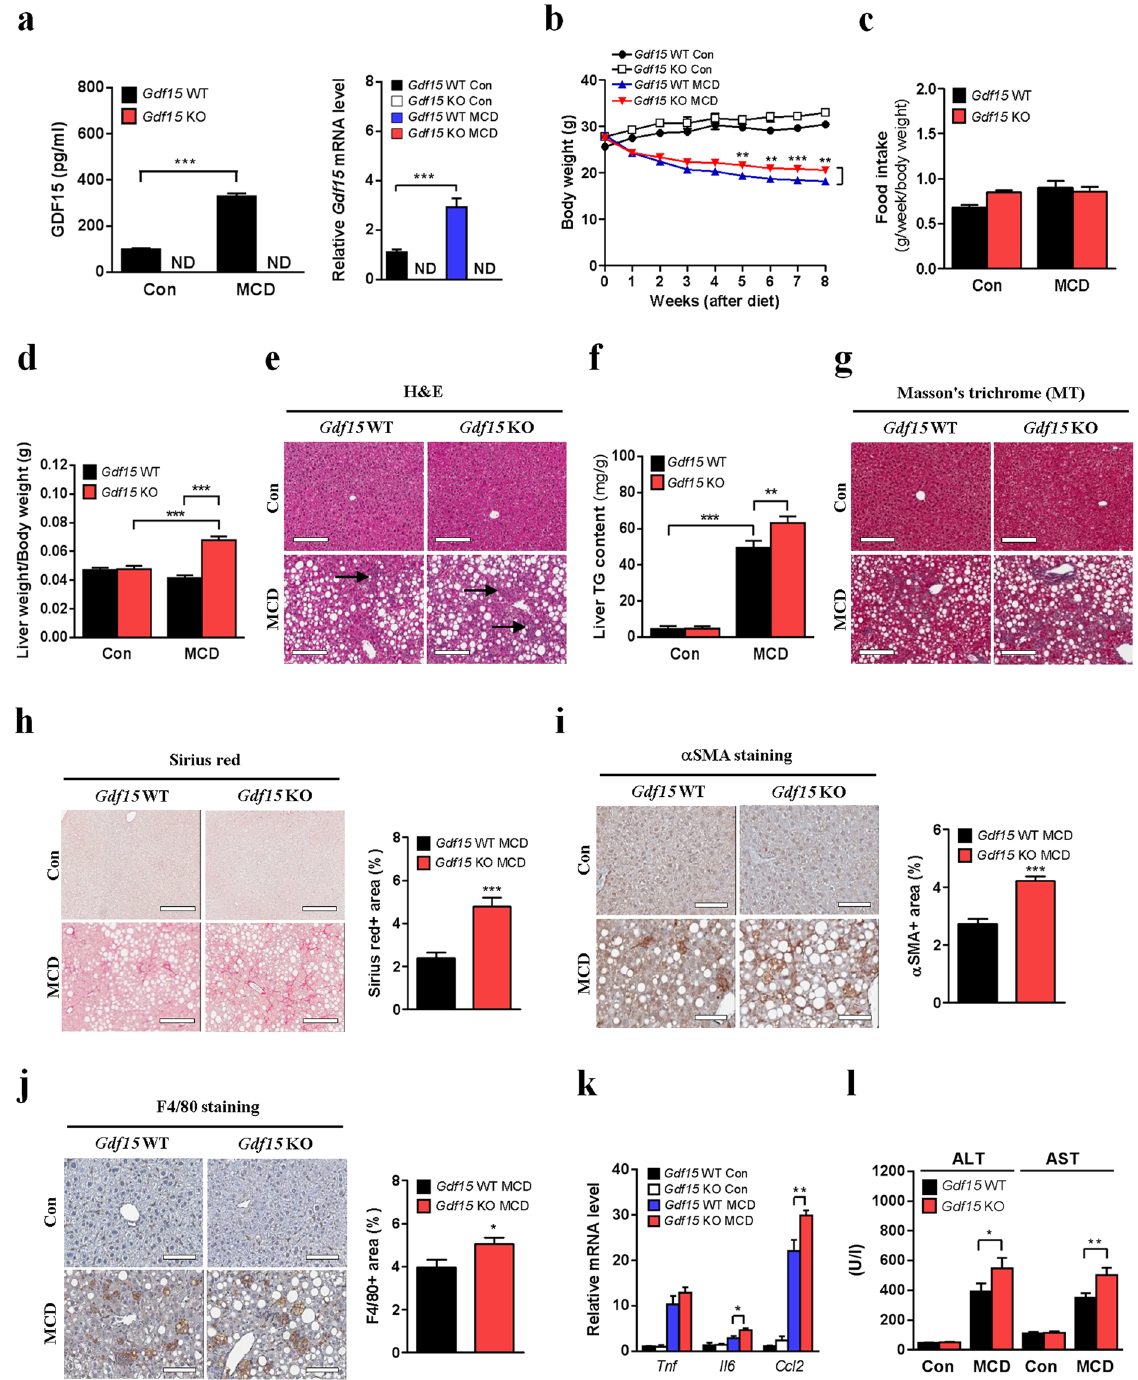
Figure 3. Gdf15 deletion accelerates NASH in mice fed MCD diet for 8 weeks. ( a ) Serum GDF15 level (left panel, n = 5–7) and relative hepatic Gdf15 mRNA level (right panel, n = 3–4). ND indicates not detected. ( b ) Body weight (n = 5–7). ( c ) Food intake adjusted for body weight (n = 5–7). ( d) Liver weight adjusted for body weight (n = 5–7). ( e ) Liver H&E staining. Arrows indicate inflammatory loci. ( f ) Liver TG content (n = 5–7). ( g) Masson’s trichrome (MT) staining. ( h) Sirius red staining and quantification. ( i ) α SMA immunostaining and quantification. ( j) F4/80 immunostaining and quantification. ( k ) Relative inflammatory gene expression (n = 3–4). ( l ) Serum ALT/AST levels (n = 5–7). Scale bars for H&E, MT and Sirius red staining, 200 μ m. Scale bars for α SMA and F4/80 immunostaining, 100 μ m. Data are means ± SEM. * p < 0.05, ** p < 0.01, *** p <